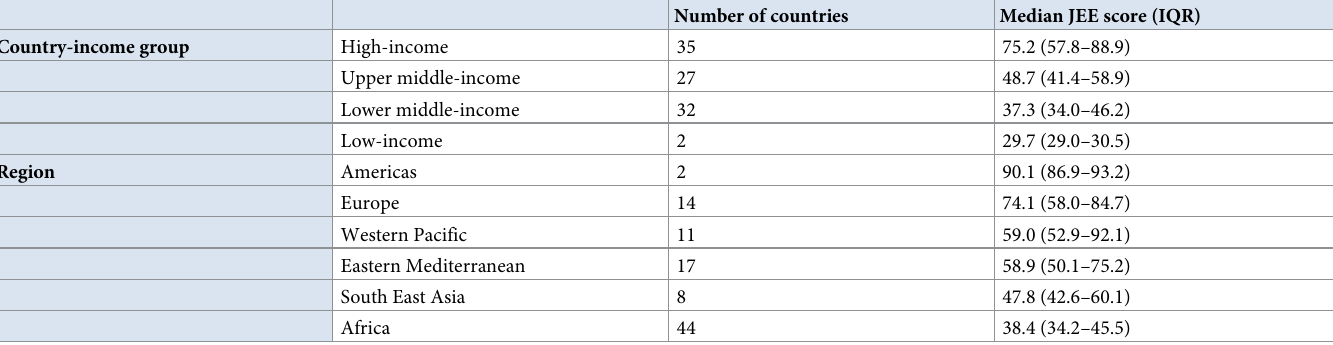
Table 1. Joint External Evaluation scores by country-income group and geographical region (N = 96).